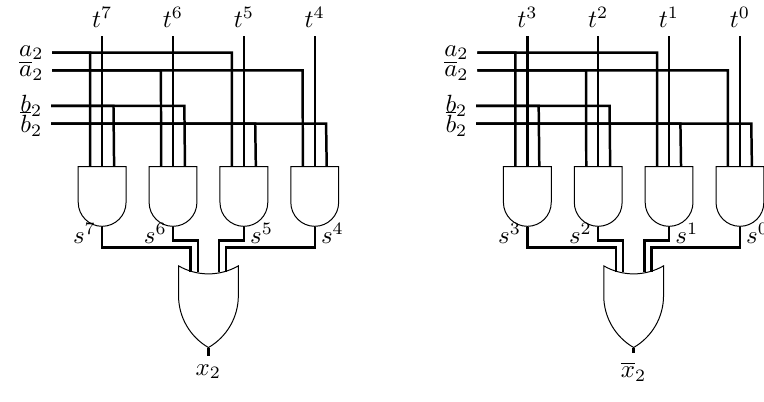
Figure 2: Combinational logic of a nonlinear LMDPL Gadget’s operation